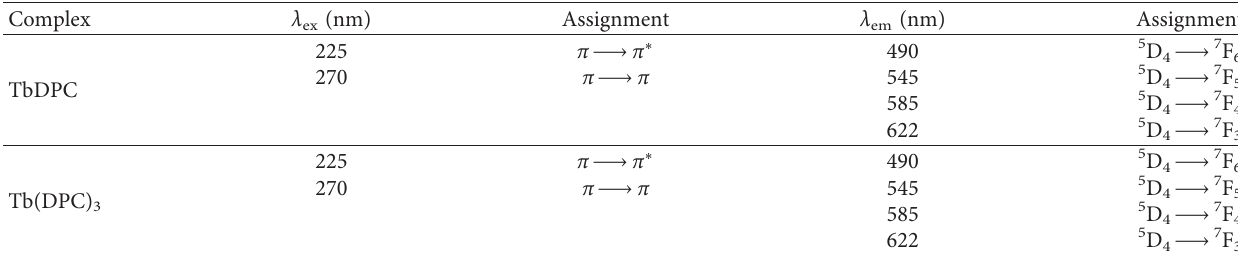
Emission spectra at λ ex � 270nm and λ ob � 545nm; emission and excitation slit widths: 5nm; PMT voltage: